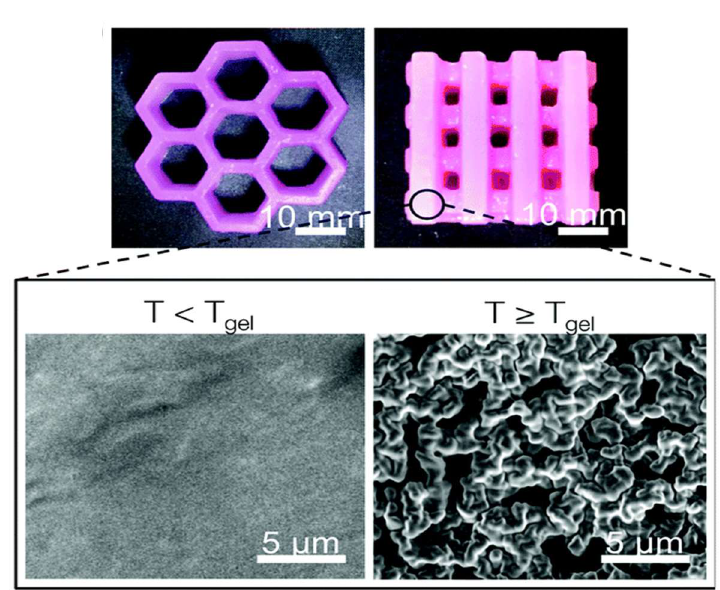
Figure 4. SLA 3D printing of honeycomb and woodpile structured hydrogels using thermoresponsive nanoemulsion inks (modified from [59]).